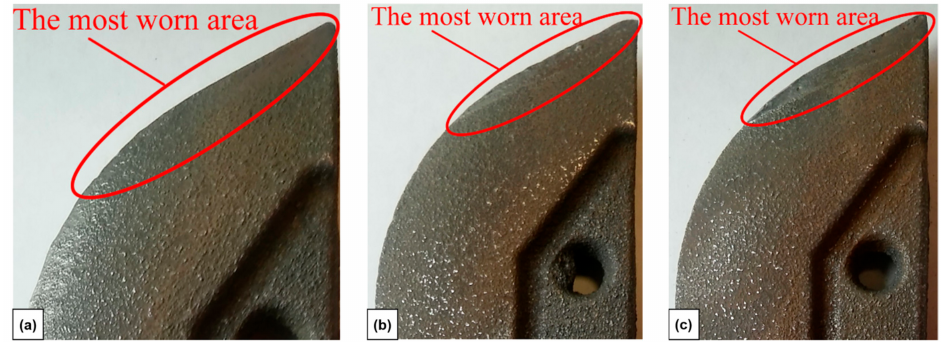
Figure 15. The cultivator coulter (after tribological test): without laser modification ( a ), after laser implantation of nickel ( b ) and combination of nickel and chromium ( c